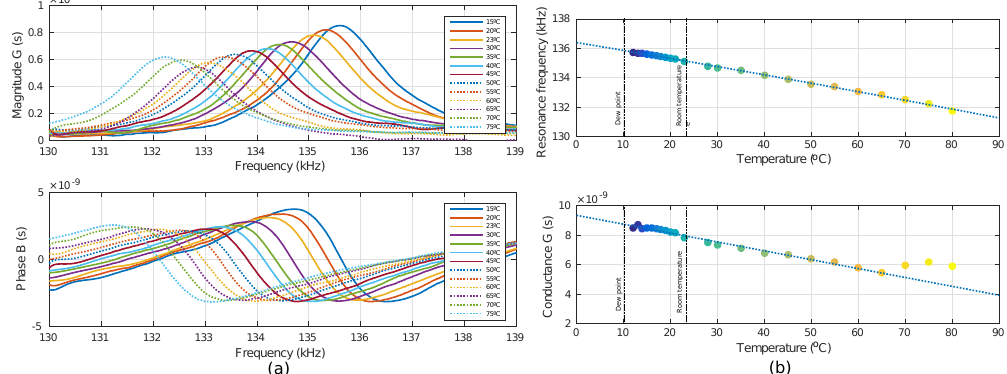
Figure 9. Temperature measurements of prototype A 1 . ( a ) Characteristic curves of the measured conductance of the sensor. ( b ) Fitting of temperature measurements from 12 ◦ C to 80 ◦ C against both resonant frequency and